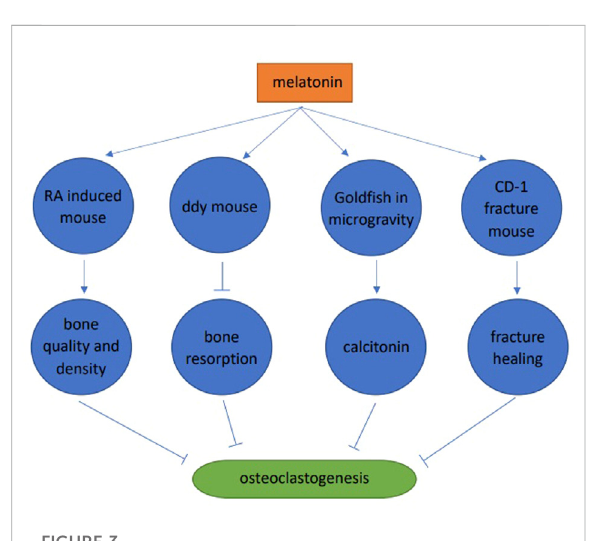
FIGURE 3 Animal studies of melatonin and osteoclast